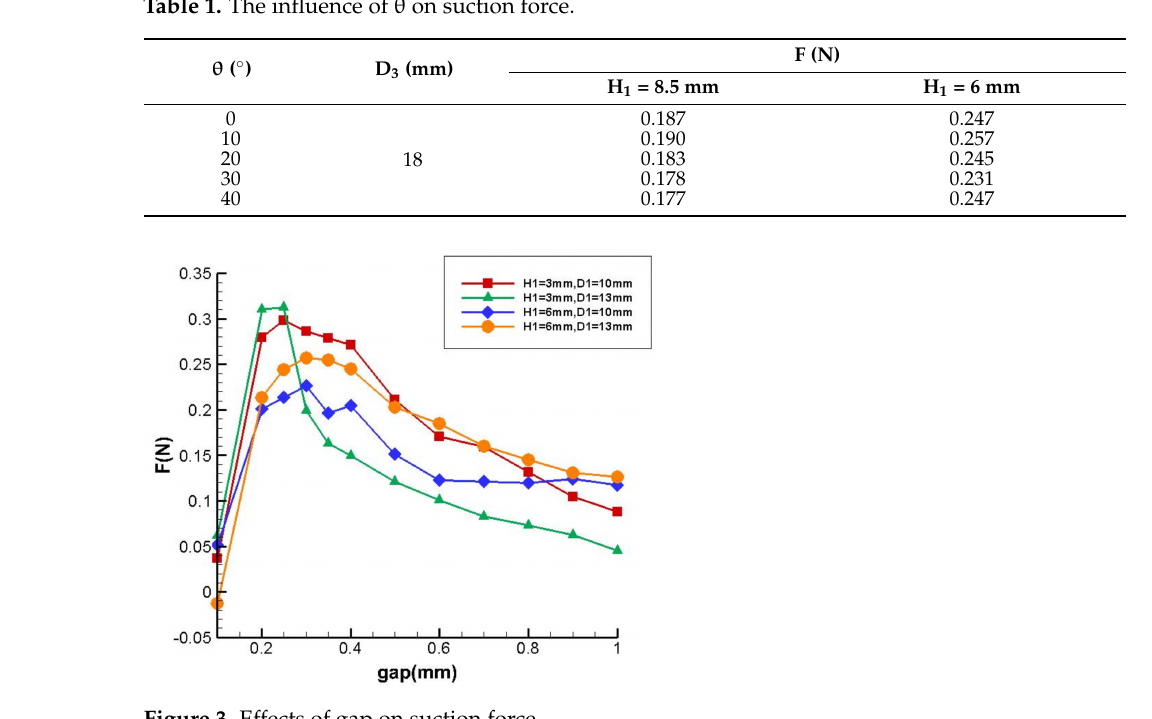
Figure 3. Effects of gap on suction force.